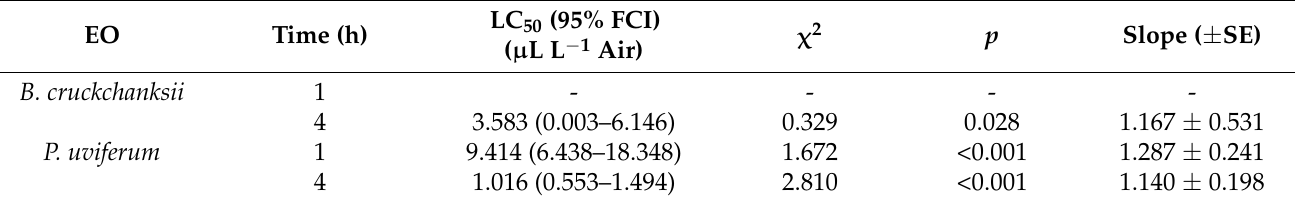
flies). The LC 50 values for P. uviferum EO were 9.41 µ L L − 1 air at 1 h. With the increased